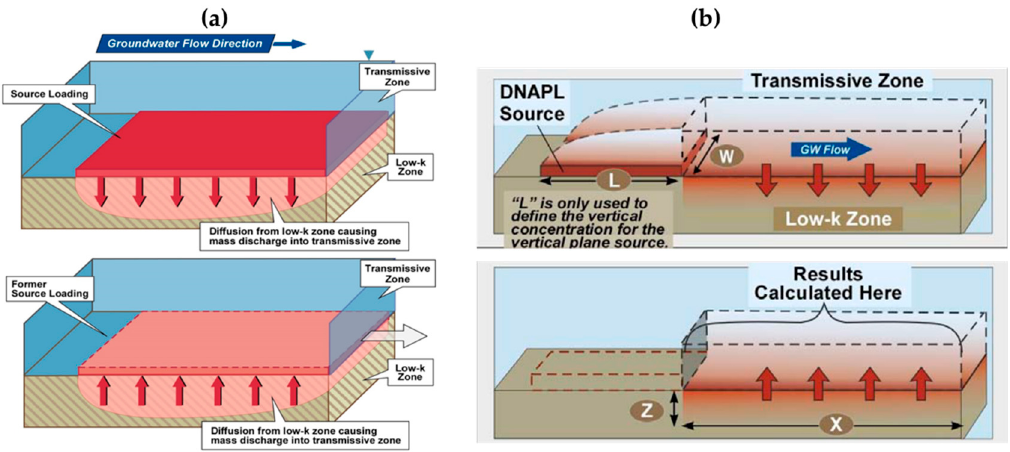
Figure 4. Square root model (SRM) ( a ) and Dandy–Sale model (DSM) ( b ) operation schemes [48].